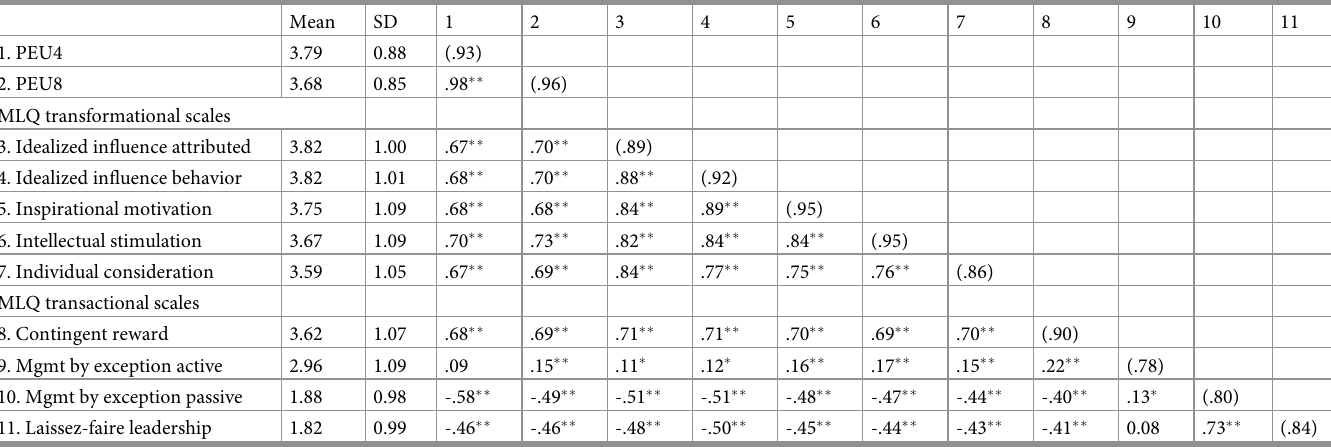
Table 6. Descriptive statistics, correlations, reliabilities for discriminant validity of PEU and MLQ (Study 3).